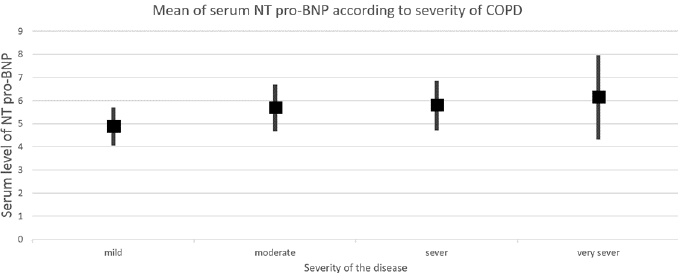
Figure 1. Mean of serum NT pro-BNP according to severity of COPD